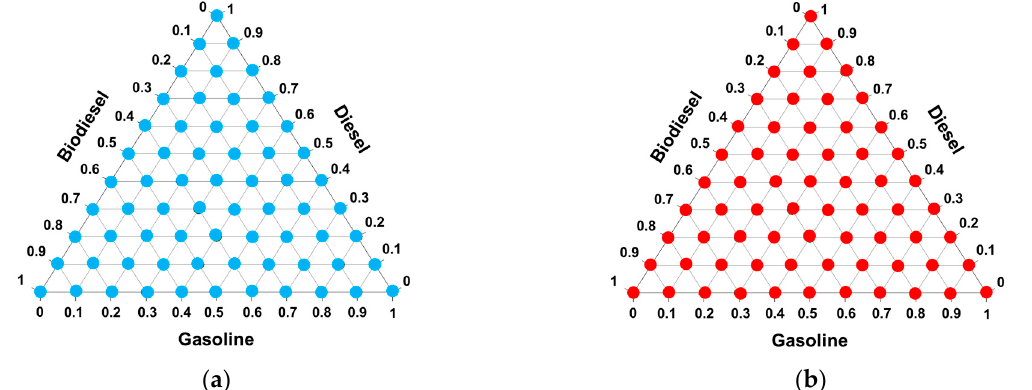
Figure 3. Ternary phase diagram of various ratio of gasoline-diesel-biodiesel blends stored at ( a ) 20–10 °C for 1 h and ( b ) 25 °C for 45 days [Adapted from 106].